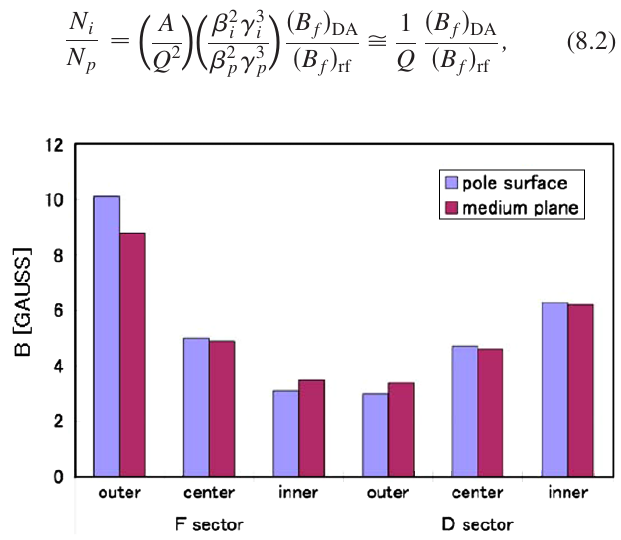
FIG. 41. Measured remanent field of the monitor magnet.